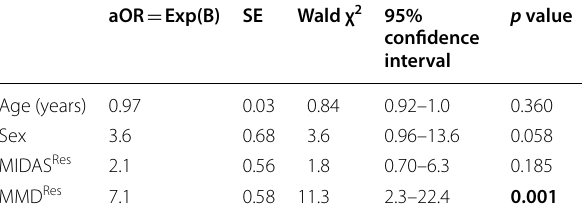
Table 3 Multivariate regression analysis of independent determinants for being Responders